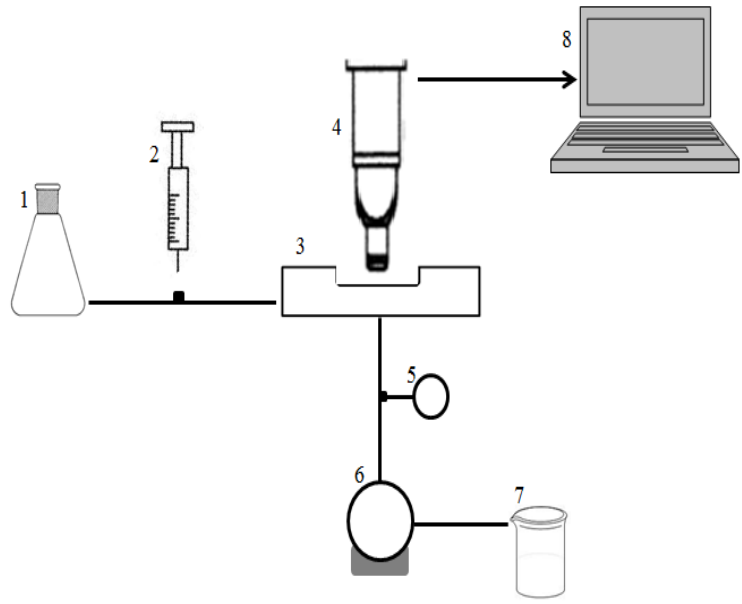
Figure 10. Schematic illustration of the microfiltration set up (1: deionized feed flask; 2: particle injection; 3: filtration chamber; 4: CLSM microscope; 5: numeric manometer; 6: pump; 7: permeate outlet; 8: